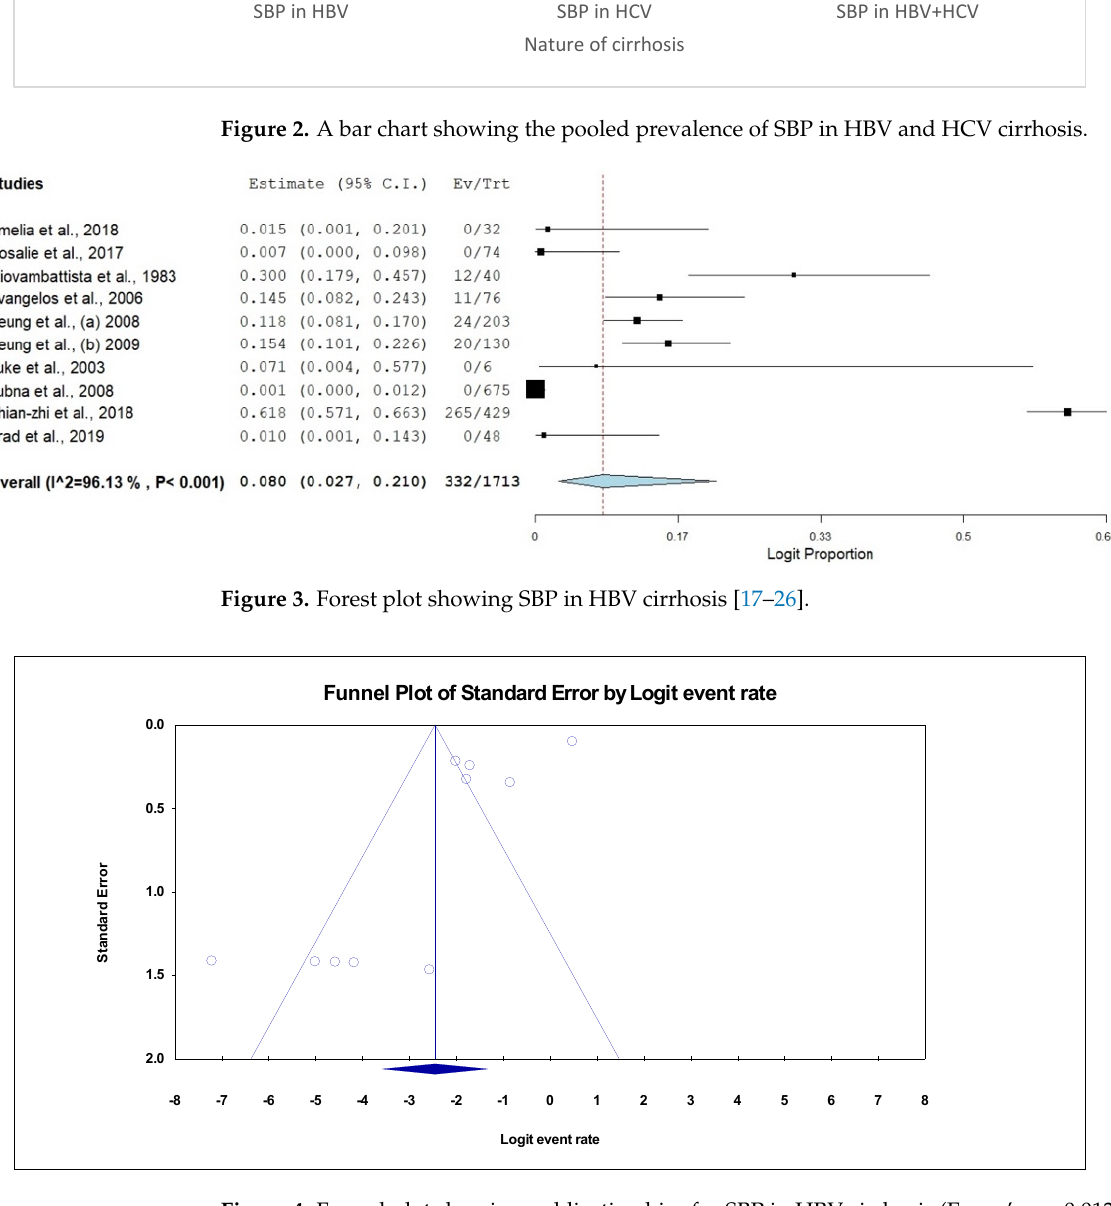
Figure 5. forest plot showing SBP in HCV cirrhosis [17–26].